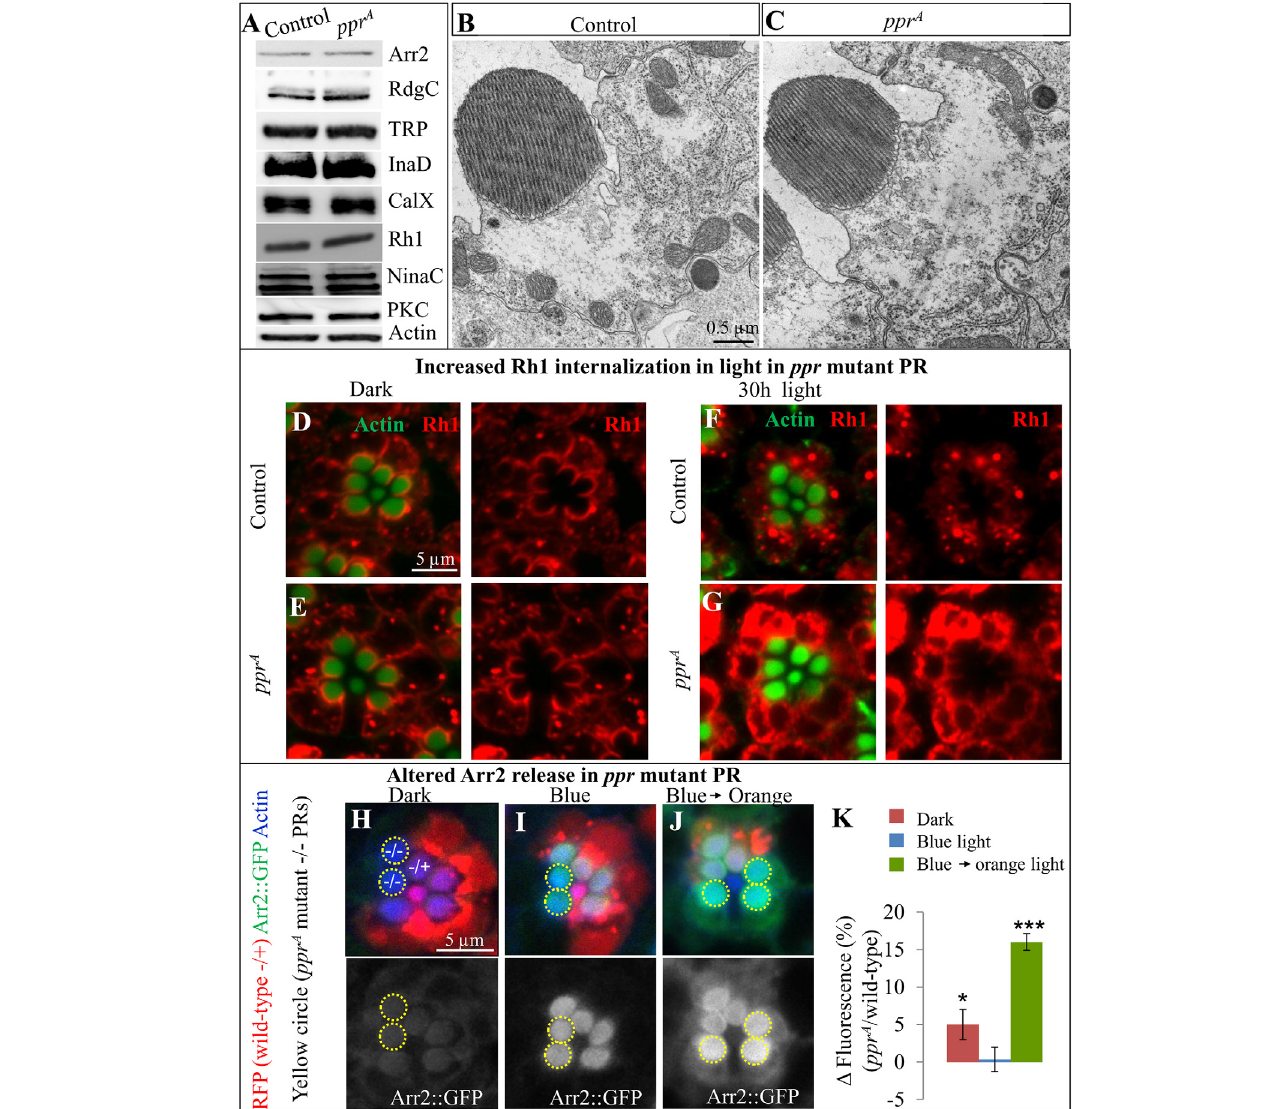
Fig 4. Light induces Rh1 accumulation in ppr mutant PRs. (A) Western blots of proteins regulating phototransduction. Protein was extracted from heads of flies containing control or ppr A mutant eyes. (B – C) TEM of a single PR from 2 – 3-d-old, dark-reared control or ppr A eye clones. (D – G) Whole mount Rh1 (red) immunostaining in control (D, F) and ppr A mutant PR (E, G). Rhabdomeres are marked by Phalloidin/Actin (green). Flies used in this experiment were 3 – 4 d old and raised in the dark (D, E) or exposed to ~30 h of light (F, G). (H – K) Arr2::GFP (green or grey) levels in rhabdomeres of ppr A mosaic retina. RFP (red) marks wild-type PRs (-/+) and yellow dotted lines encircle ppr A mutant PRs (-/-, lacking RFP). Rhabdomeres are costained with Phalloidin/Actin (blue). Flies were raised in constant dark and dissected and fixed under dim red light. Prior to fixation, flies were kept in dark (H) or blue light (I) for 1.5 min, allowing Arr2::GFP to translocate to rhabdomeres. Alternatively, flies were kept in blue light for 30 min and then shifted to orange light for 60 min to assess release of Arr2::GFP from rhabdomeres (J). (K) Quantification of the difference in green fluorescence intensity between mosaic ommatidia of ppr and wild-type rhabdomeres. Error bars represent ± SEM; statistical significance was determined using a two-tailed Student ’ s t test ( p -values: * < 0.05, *** < 0.001).